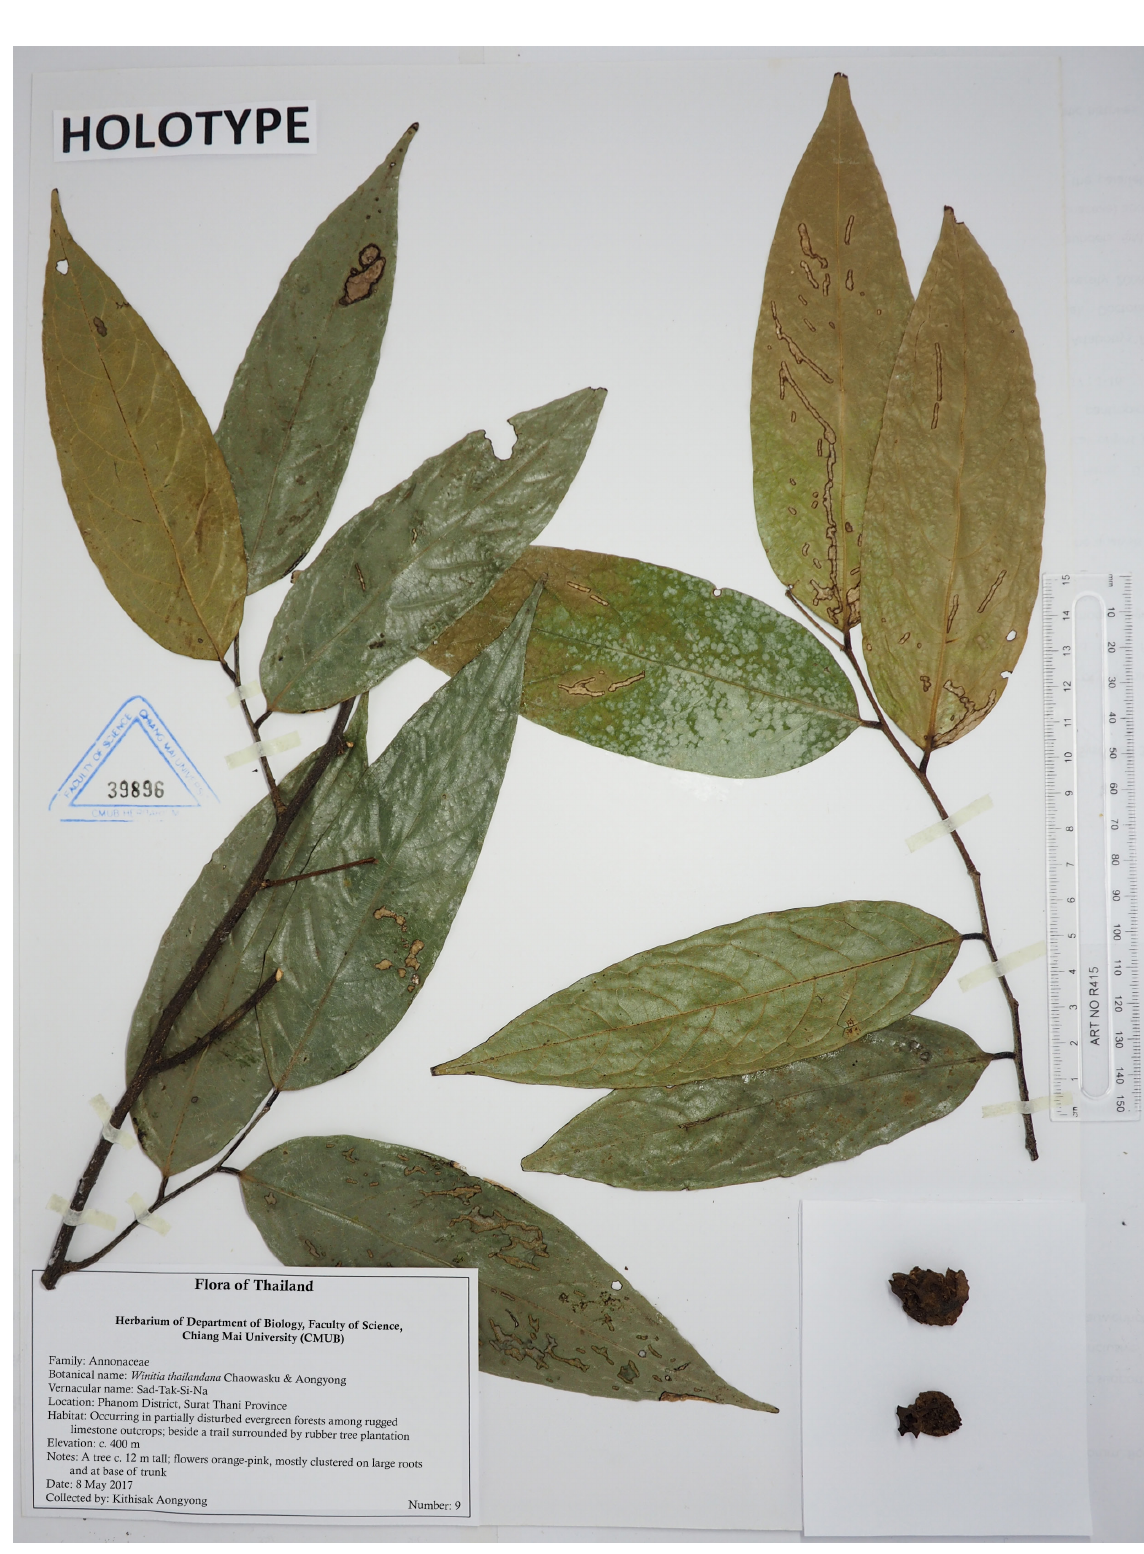
Fig. 5. Holotype of Winitia thailandana Chaowasku & Aongyong sp. nov. at